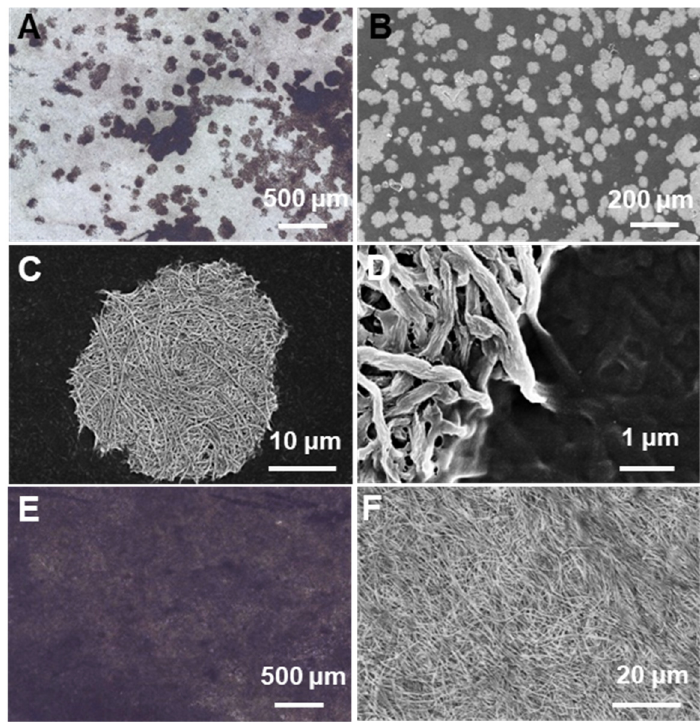
Figure 5. Partially and fully growth collagen fi lms. ( A ) Optical image of partially growth collagen fi lm. ( B ) SEM image of the partially growth collagen fi lm. ( C ) SEM image of an isolated growth area. ( D ) SEM image of the edge of the isolated area. ( E ) Optical image of the full growth fi lm. ( F ) SEM image of the full growth collagen fi